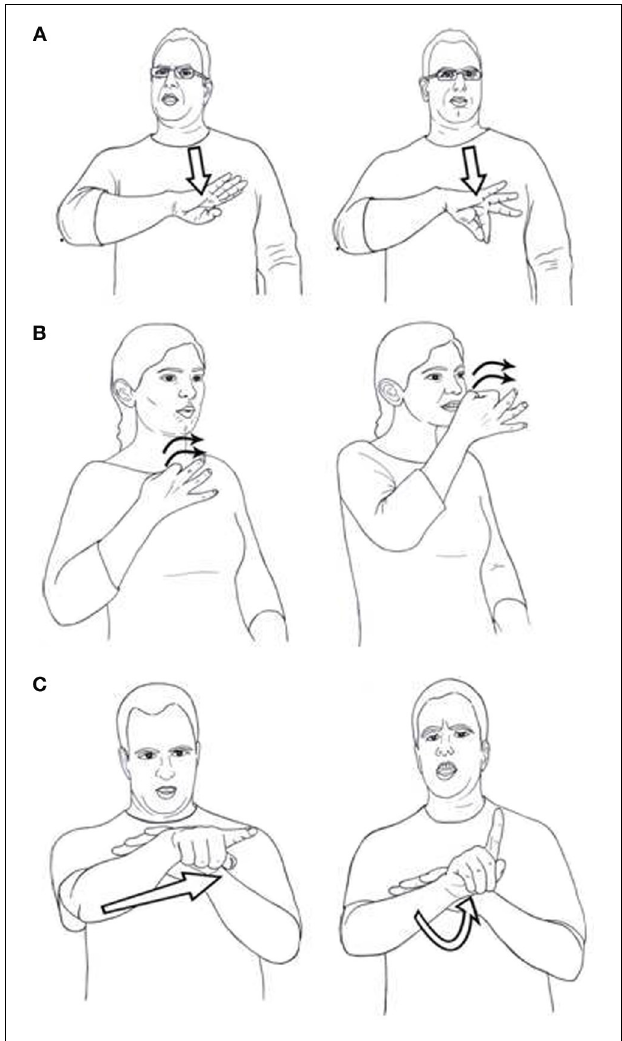
FIGURE 2 | (A) Two identical signs in ISL and KQSL: bird. (B) Two similar signs in ISL and KQSL: TELEVISION . (C) Two different signs in ISL and KQSL: COW